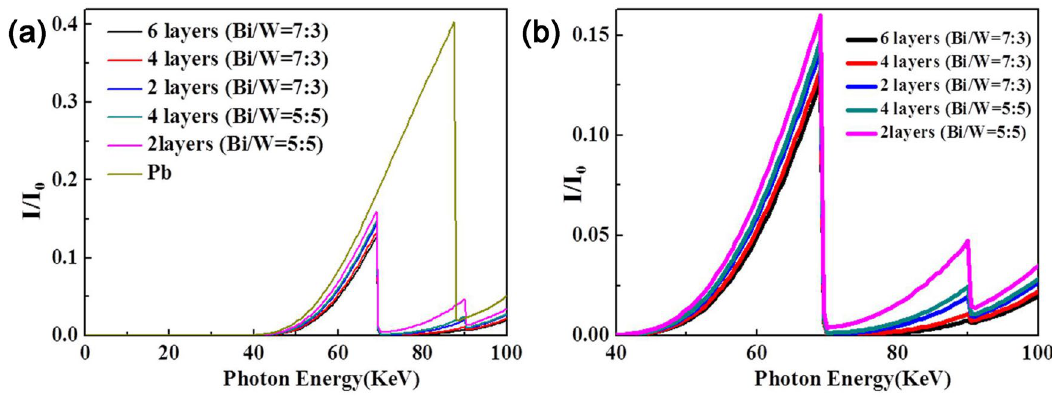
Figure 9. ( a ) The dependence of the X-ray transmittance on layer thickness ratios (7:3 and 5:5), incident direction and number layers through computer simulation; ( b ) the local magnification of ( a ) was presented in ( b ).